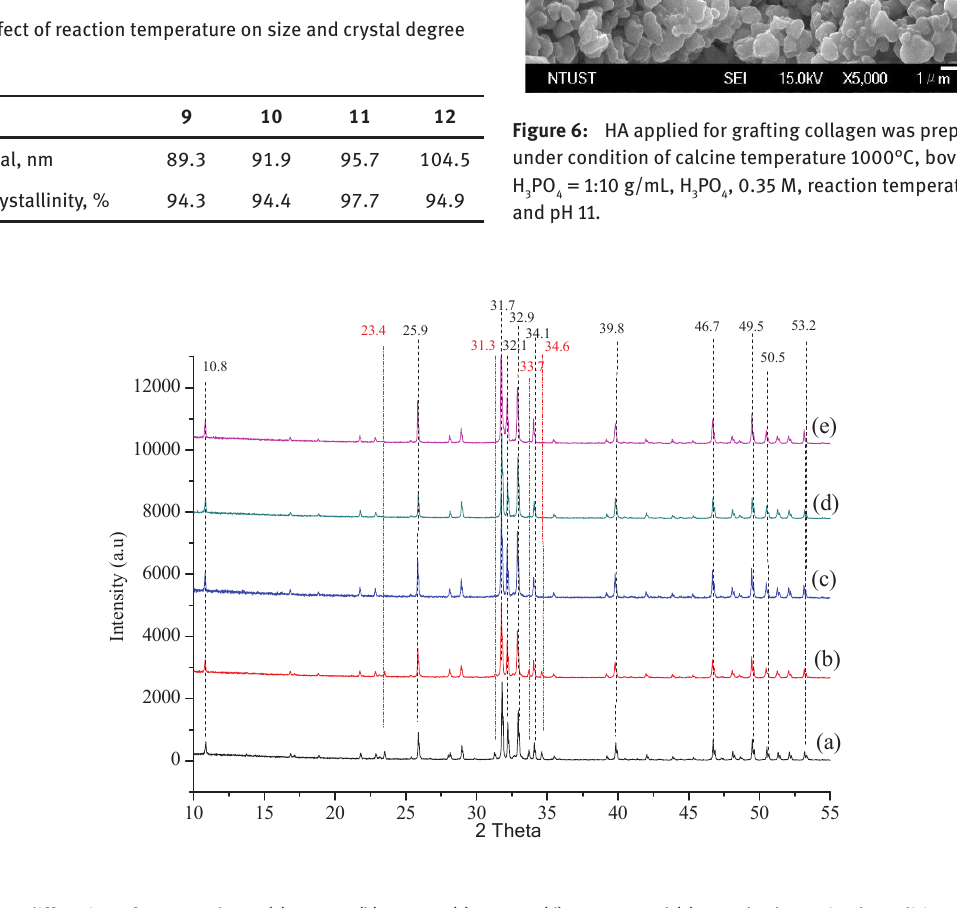
Figure 5: XRD diffraction of HA sample at: (a) 700°C, (b) 800°C, (c) 900°C, (d) 1000°C and (e) Standard HA. Fixed conditions: bovine powder/H PO = 1:10 g/mL, H PO (35 mM), reaction temperature 90°C and pH 11. 3 4 3 4